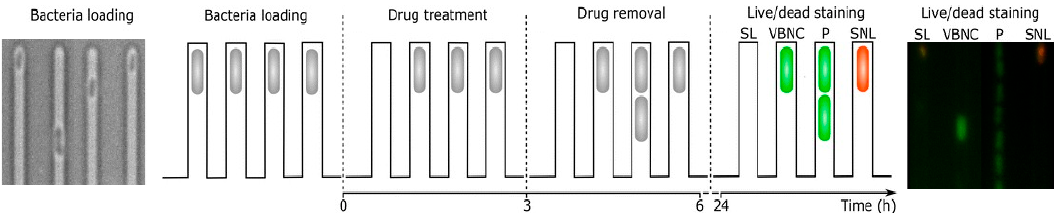
Figure 5. Single-cell microfluidic analysis of susceptible lysed (SL), VBNC (VBNC), persister (P), and susceptible non-lysed (SNL) E. coli BW25113 cells before (0 h), during (0–24 h), and after (24 h) the antibiotic treatment combined with SYTO 9 ® and PI. Live cells (green fluorescence, SYTO 9 ® ) and dead cells (red fluorescence, PI) are viewed by time-laps microscopy, adapted from [31].